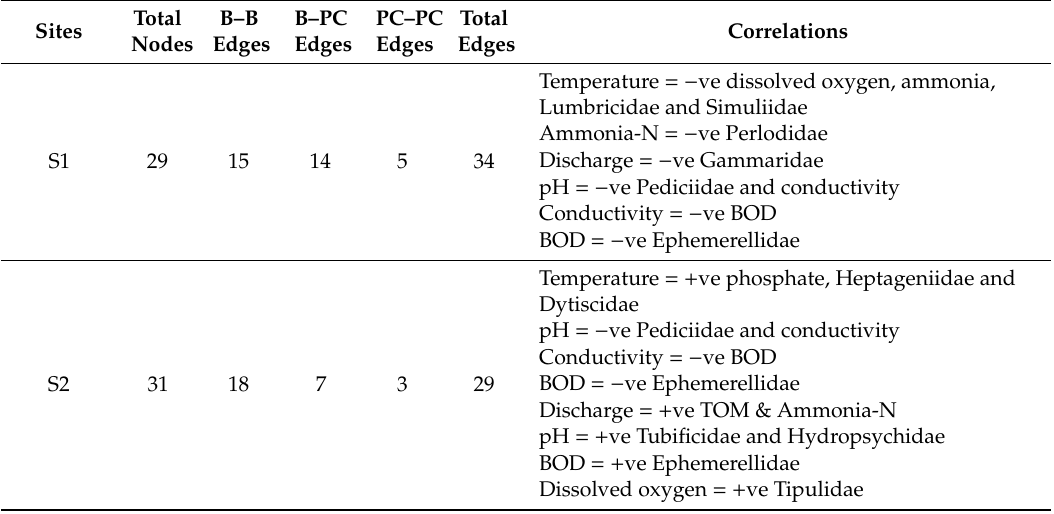
Table 3. Network node and edge counts for each site’s network based on Spearman’s correlation coe ffi cient of ρ > 0.6 and where p <